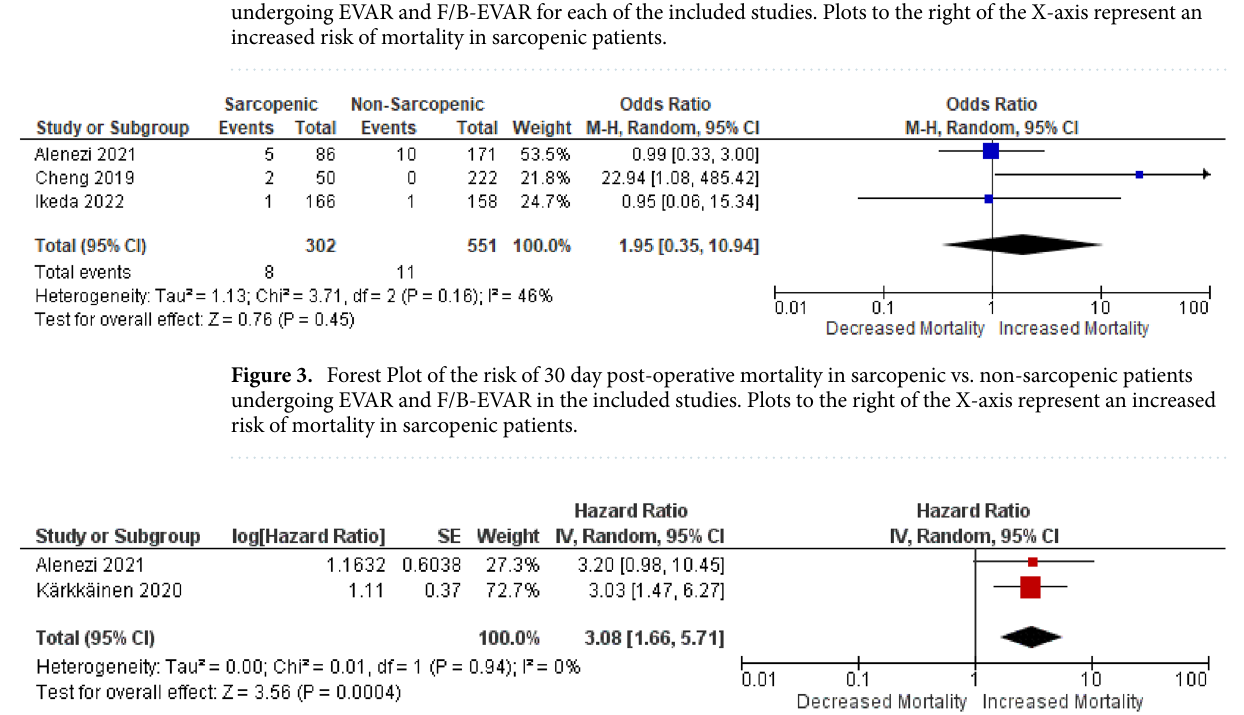
Figure 4. Forest Plot of the risk of post-operative mortality in sarcopenic vs. non-sarcopenic patients undergoing F/B-EVAR for the included studies. Plots to the right of the X-axis represent an increased risk of mortality in sarcopenic